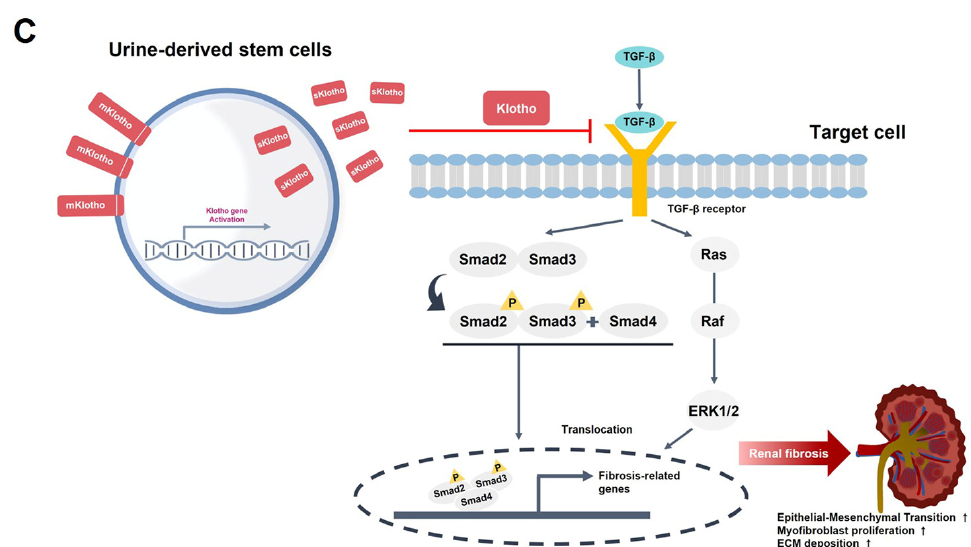
Figure 6. UDSCs suppress fibrosis in HK-2 cells via the TGF- β /ERK signaling pathway. ( A ) In total, 10 ng/mL TGF- β 1-treated HK-2 were co-cultured with normal UDSCs or si-Klotho UDSCs for 72 h. The TGF- β /ERK signaling pathway was analyzed by Western blotting using HK-2 cell lysates. ( B ) Klotho expressions were analyzed by Western blotting using HK-2 cell lysates. The results are shown as the mean ± SEM. * p < 0.05, ** p < 0.01, *** p < 0.001 vs. Control. ( C ) Schematic diagram of the mechanism of UDSC-derived Klotho.